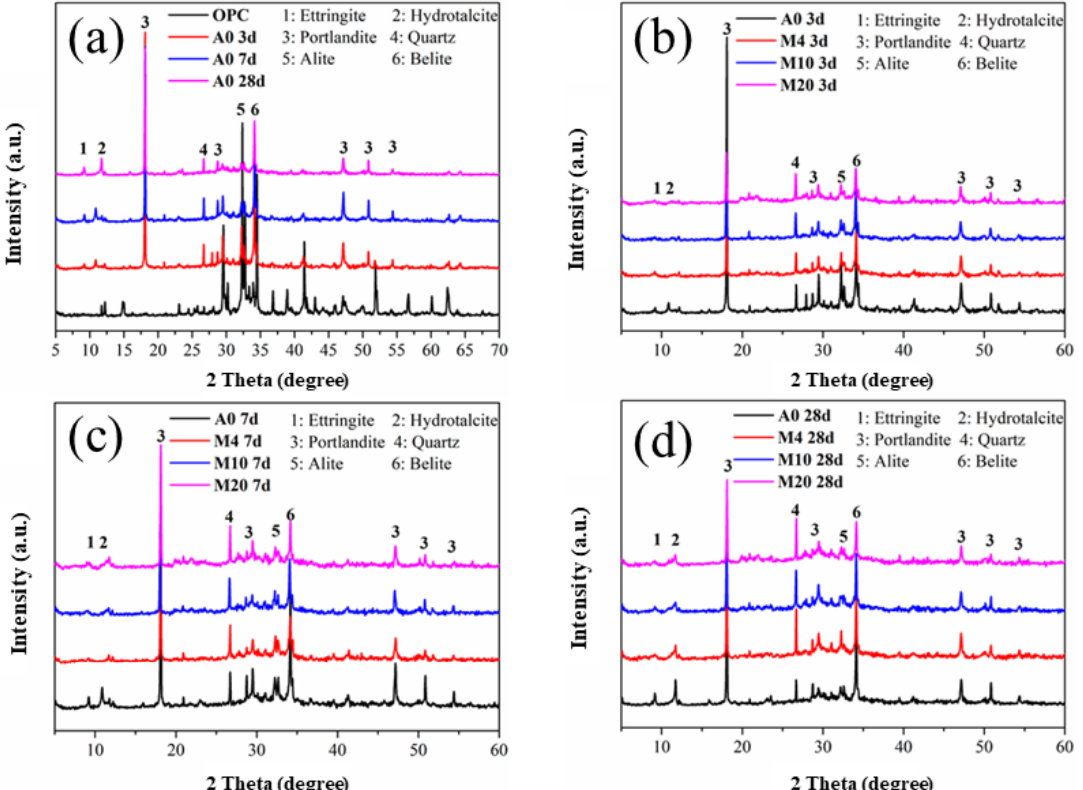
Figure 11. Phase composition analysis of calcined montmorillonite cement paste mixed with different amounts at different ages. ( a ) Control group(A0) at different age; ( b ) Different dosage at day 3; ( c ) Different dosage at day 7; ( d ) Different dosage at day 28.